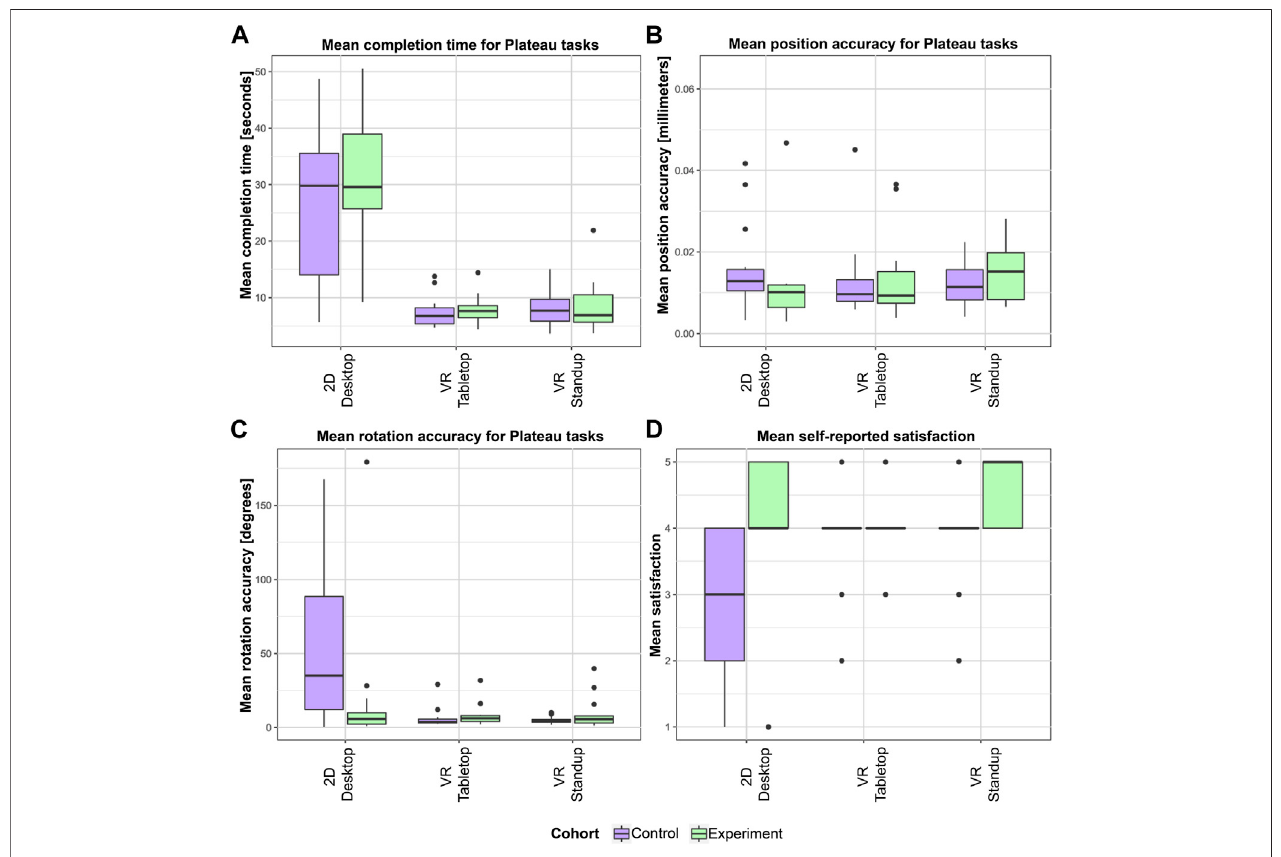
FIGURE 9 | Mean completion time (A) , position accuracy (B) , and rotation accuracy (C) for Plateau tasks as well as satisfaction (D) in all setups for both cohorts.